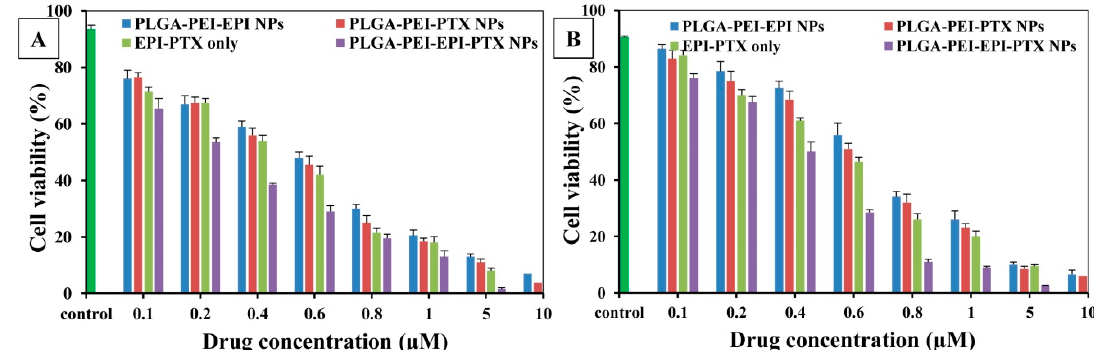
Figure 8. Cell viability as determined by MTT assay. The % cell viability of A549 cells treated with PLGA-PEI-EPI NPs, PLGA-PEI-PTX NPs, EPI-PTX only and PLGA-PEI-EPI-PTX NPs, at ( A ) 24 h time point, ( B ) 48 h time point. Data are shown as mean ± SD ( n = 3).